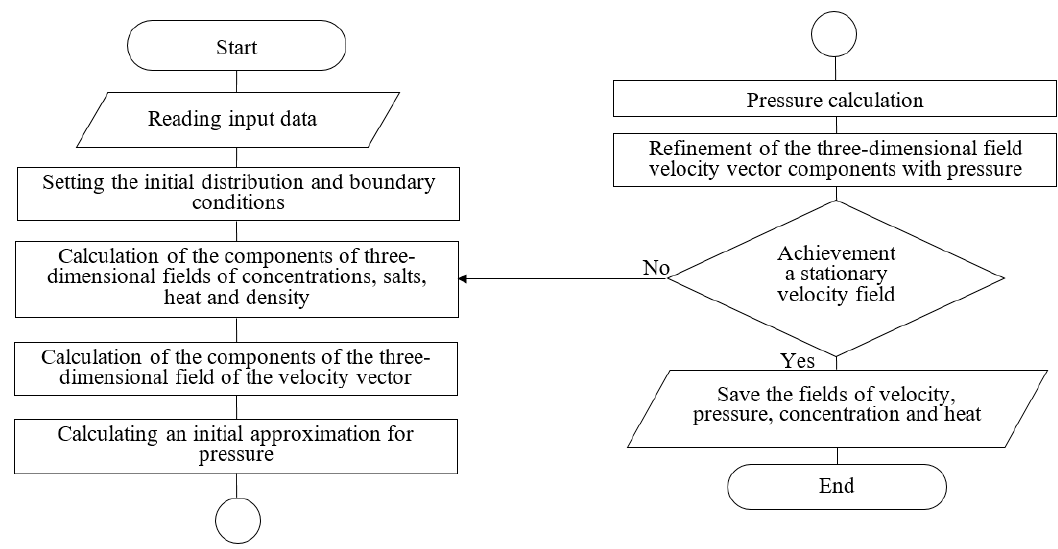
Figure 3. Program module block